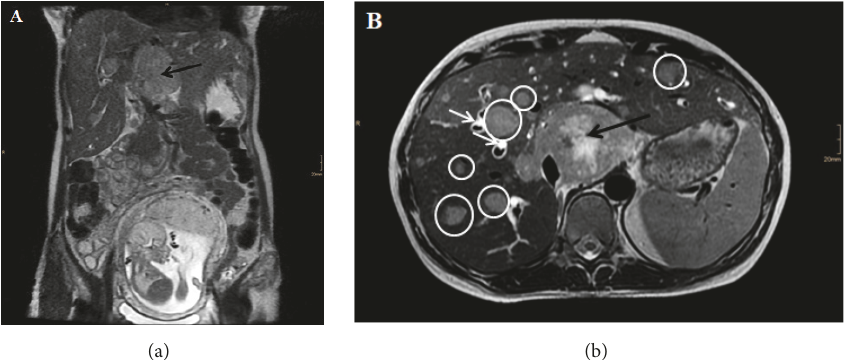
Figure 1: Magnetic resonance imaging (MRI) shows an enlarged liver with central tumor (black arrow), dilated biliary ducts (white arrows), and disseminated metastases (circles) of a pregnant woman at 20 weeks 4 days of gestation. (a) coronal, (b) axial view.